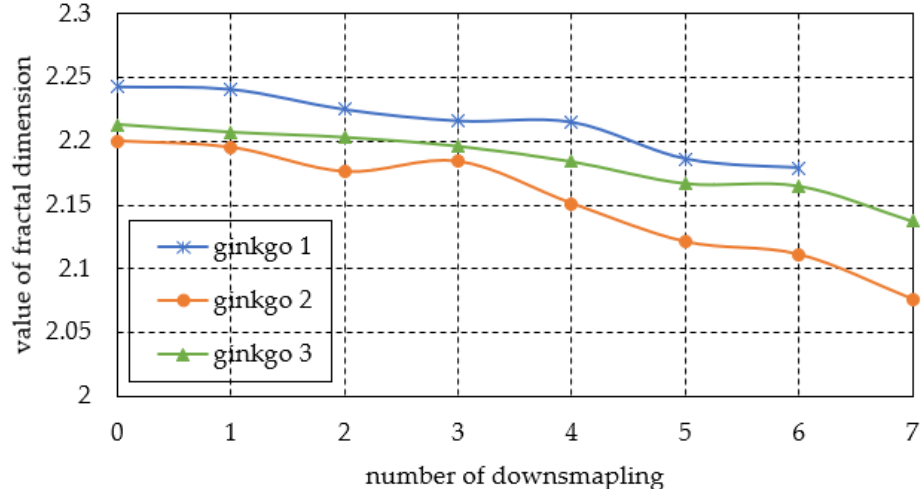
Figure 7. Trend of the fractal dimension with point cloud down sampling of ginkgo trees 1 to 3.